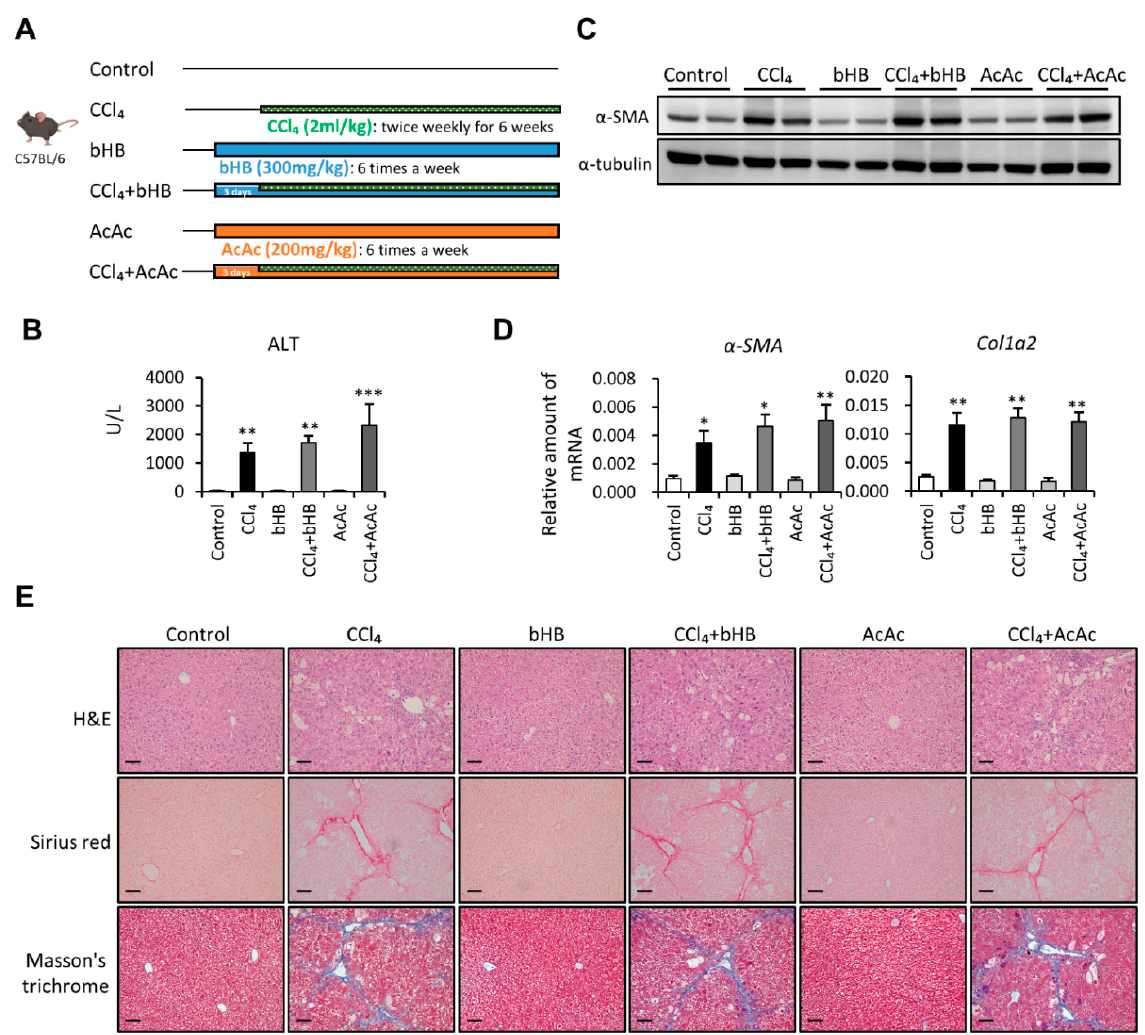
Figure 5. Ketone body supplementation did not influence the severity of CCl 4 -induced liver fibrosis. ( A ) Study design of the in vivo experiment. ( B ) Serum samples were collected at the end of the experiment, and the serum ALT was assessed. ( C ) Representative results from Western blot analyses of α -SMA expression and ( D ) qPCR analyses of α -SMA and Col1a2 gene expression. ( E ) Representative H&E, Sirius red, and Masson’s trichrome staining images of liver tissues. Scale bars: 0.1 mm. *, p < 0.05; **, p < 0.01; ***, p < 0.001 vs. relative control. N = 5 in each group. Data are shown as mean ± SEM.